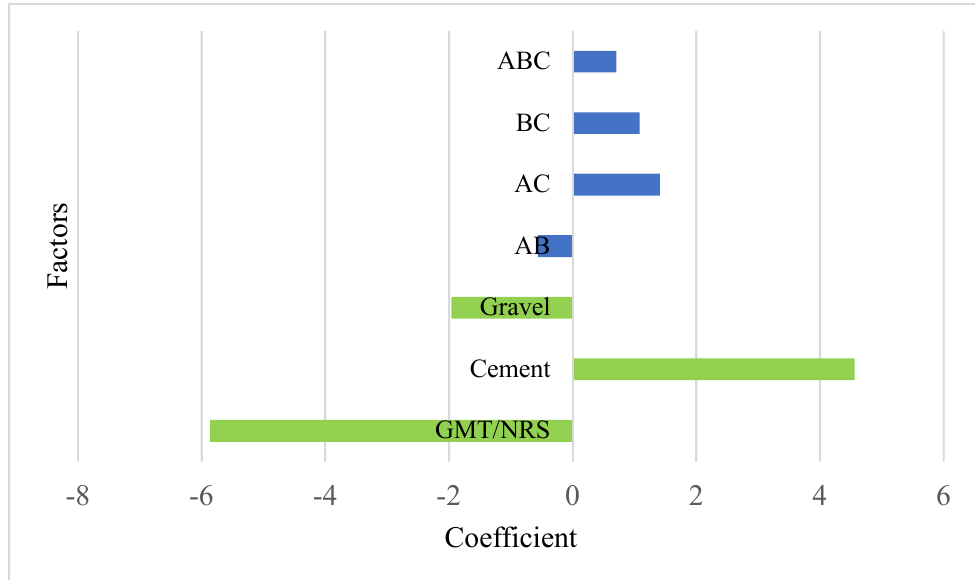
Figure 2. Horizontal bar diagram of the influence of each factor on the response.